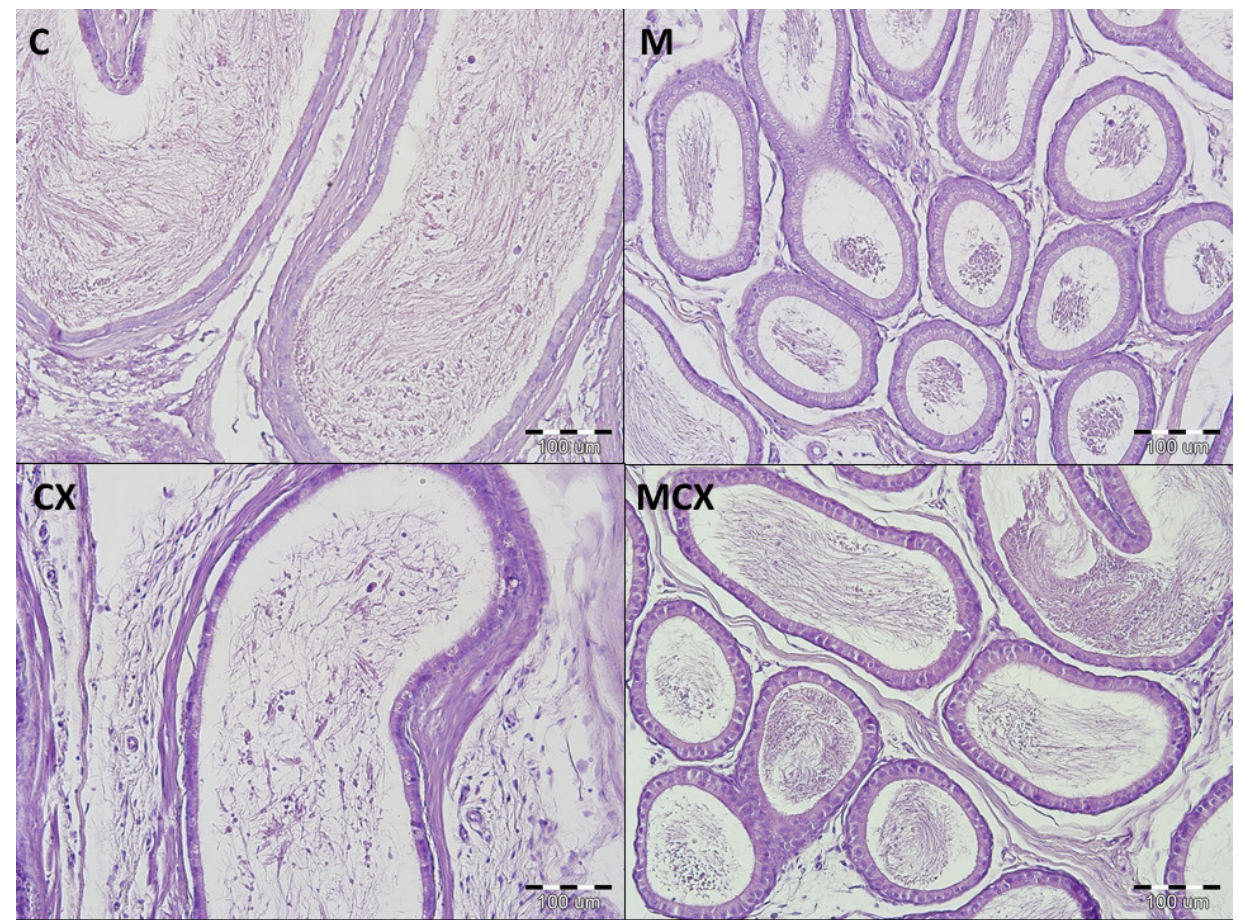
Figure 4. Histological cross-sections of epididymes (HE staining, magnification 200×). C—control group—no pathological changes, tubules have thick muscular coat, the lining is composed of tall, ciliated columnar cells, without atypia; M—NaMSA receiving group—no pathological changes, tubules have thick muscular coat, the lining is composed of tall, ciliated columnar cells, without atypia; CX—cyclophosphamide receiving group—changes grade 1—tubules have thick muscular coat, the lining is composed of tall, ciliated columnar cells, with some discrete changes; MCX—group receiving cyclophosphamide and NaMSA—no pathological changes, tubules have thick muscular coat, the lining is composed of tall, ciliated columnar cells, without atypia.